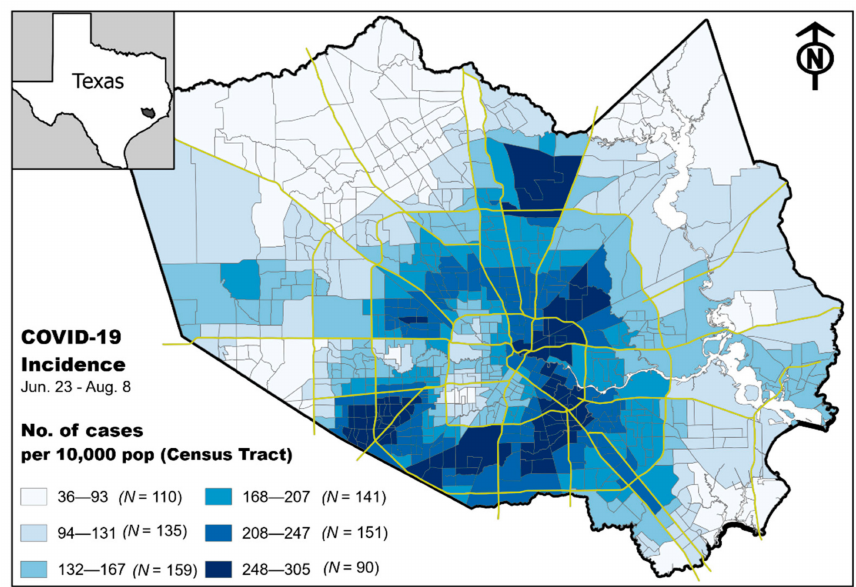
Figure 2. Maps of Texas showing Harris County and a zoomed-in version of the county. Choropleth map depicts the incidence of COVID-19 (cases per 10,000 population) between 23 June 2020 and 3 August 2020 at the census tract level ( N =